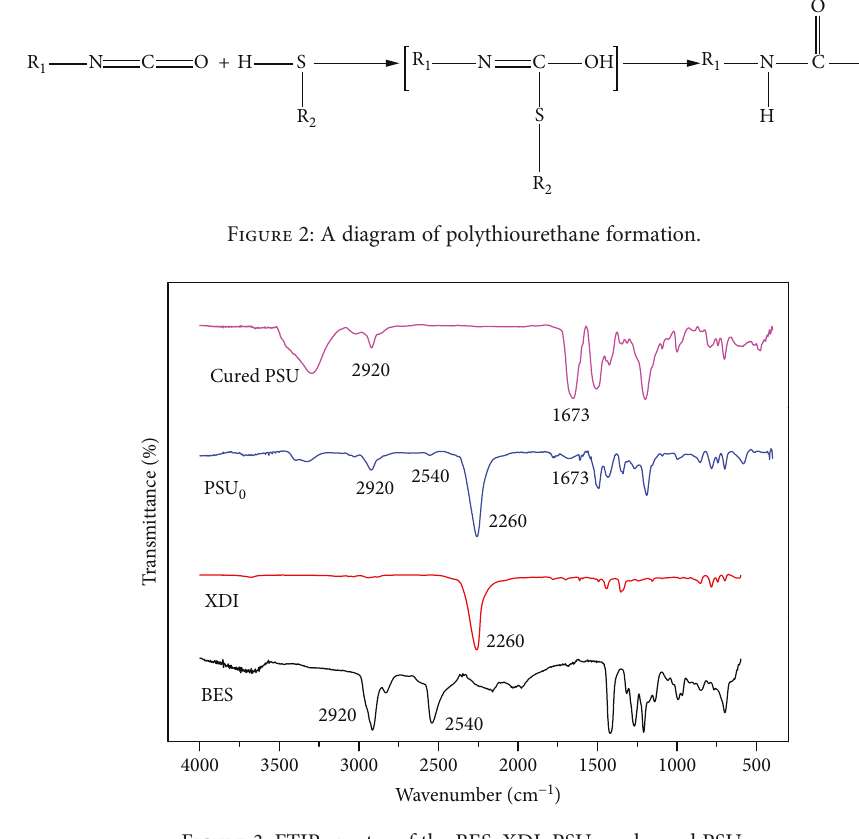
Figure 3: FTIR spectra of the BES, XDI, PSU